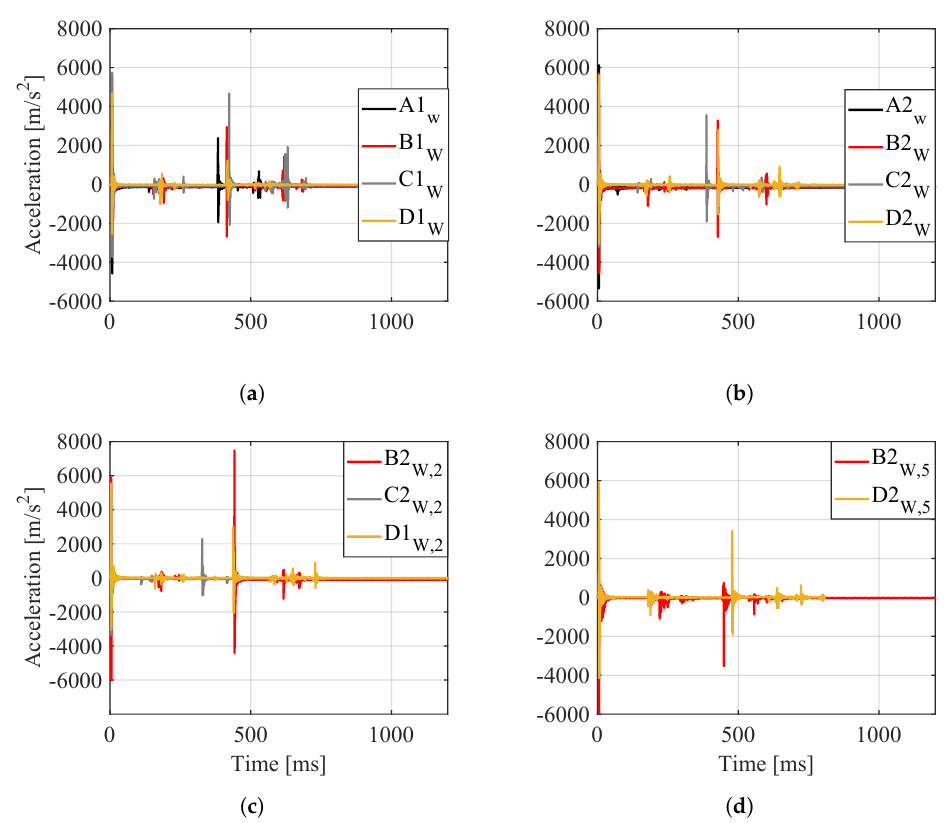
Figure 10. ( a ) Entire signal measured at the west accelerometer for Beams A1–D1 during the first impact test; ( b ) signal during the first impact test for Beams A2–D2; ( c ) signal during the second impact test for Beams B2–D2; and ( d ) signal during the fifth impact test for Beams B2 and D2. The acceleration after signal processing, time-integrated velocity, and time-integrated displacement are shown in Figure 11 for Beams A1–D1. The response 20 ms after the development of the initial peak shown in Figure 10 was studied. The variation of velocity in time presented in Figure 11c,d shows a similar response for Beams B1 and C1. Their dominating frequency 10 ms after retardation, where free vibration of the beams in the linear range of internal force occurs, is larger than that observed for Beams D1 and A1. The reduced dominating frequency of Beams D1 and A1 post-retardation indicates a larger degree of damage, as a decrease in the dominating frequency points to a decrease in stiffness. The peak and residual displacement after spring-back in (e) and (f) are similar for Beams B1–D1, indicating similar global responses. Beam A1 shows less spring-back than the other beams in (f), as the propagation of significant diagonal cracks absorbs the energy imparted by the striker. The permanent displacement after the spring-back of Beam A1 is higher on the east side compared with the west side, indicating permanent shear